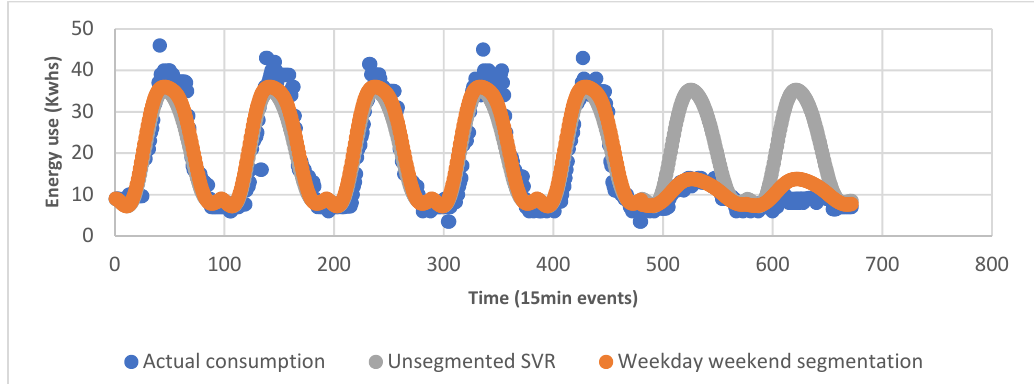
Figure A11. The first SVR predicted week of autumn.